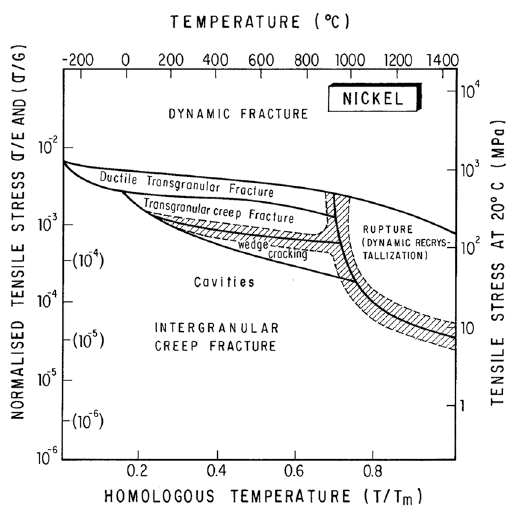
Figure 8. Experimental fracture map of Ashby et al. 7 for nickel.